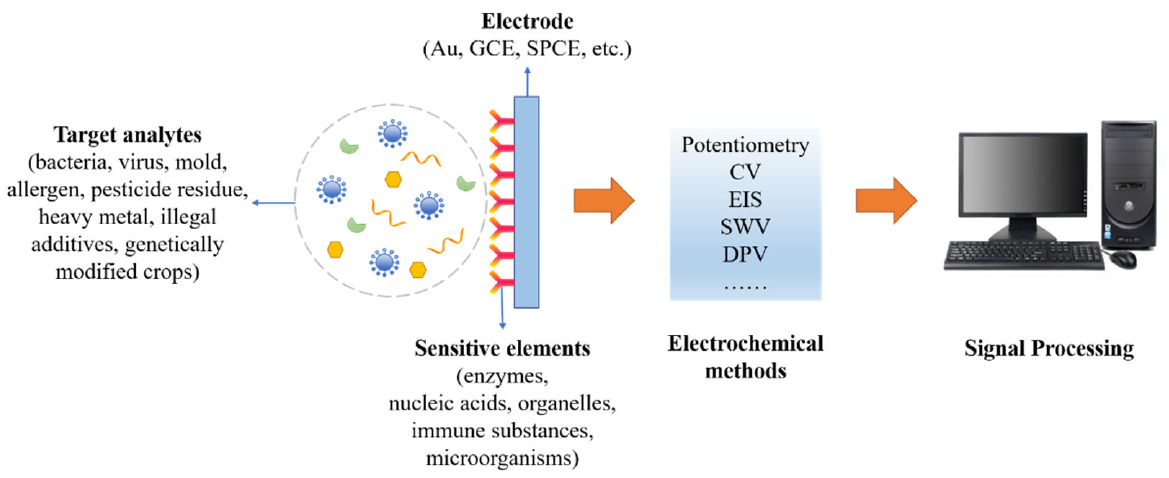
Figure 1. Schematic diagram of an electrochemical biosensor for food contaminants detection. Common electrochemical methods include potentiometry, cyclic voltammetry (CV), electrochemical impedance spectroscopy (EIS), square wave voltammetry (SWV), and dif ‐